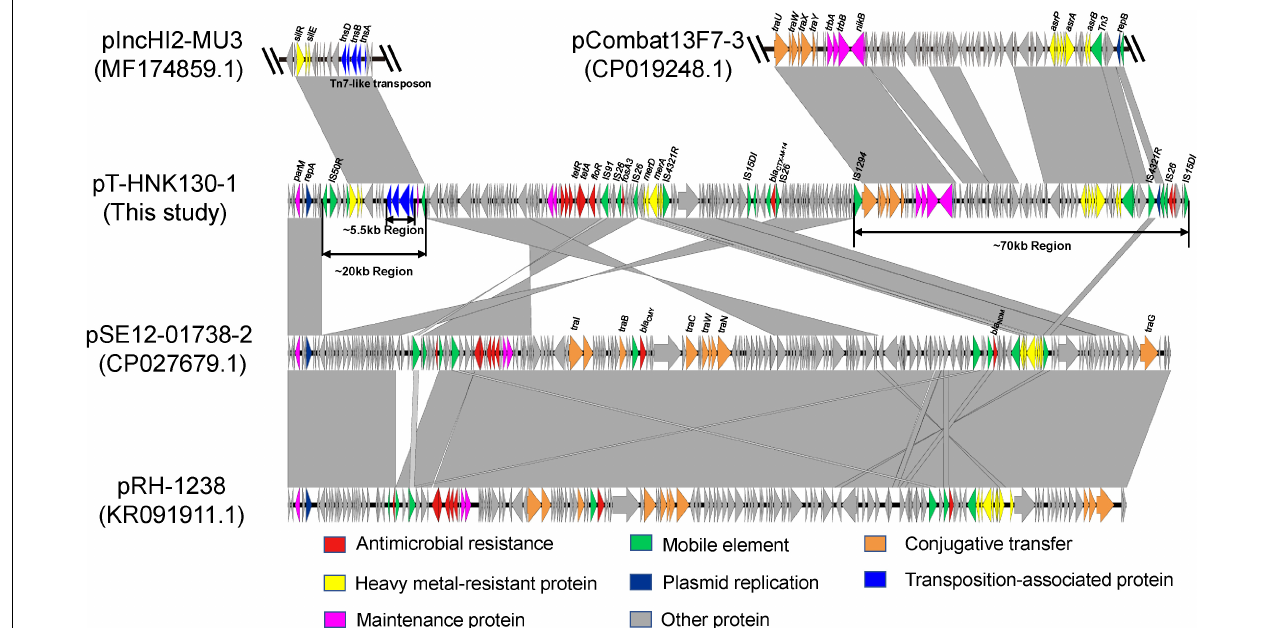
FIGURE 2 | Sequence linear comparison between pT-HNK130-1, pCombat13F7-3 (GenBank accession no. CP019248.1), pIncHI2-MU3 (accession no. MF174859.1), pSE12-01738-2 (accession no. CP027679.1), and pRH-1238 (accession no. KR091911). Gray shading indicates shared regions with a high degree of homology. Genes are represented by arrows and are colored depending on gene function as depicted. Genes are color coded as follows: dark blue, replication; green, mobile element; red, antimicrobial resistance; yellow, heavy metal–resistant protein; blue, transposition-associated protein; orange, conjugative transfer; rose red, maintenance protein; gray, other